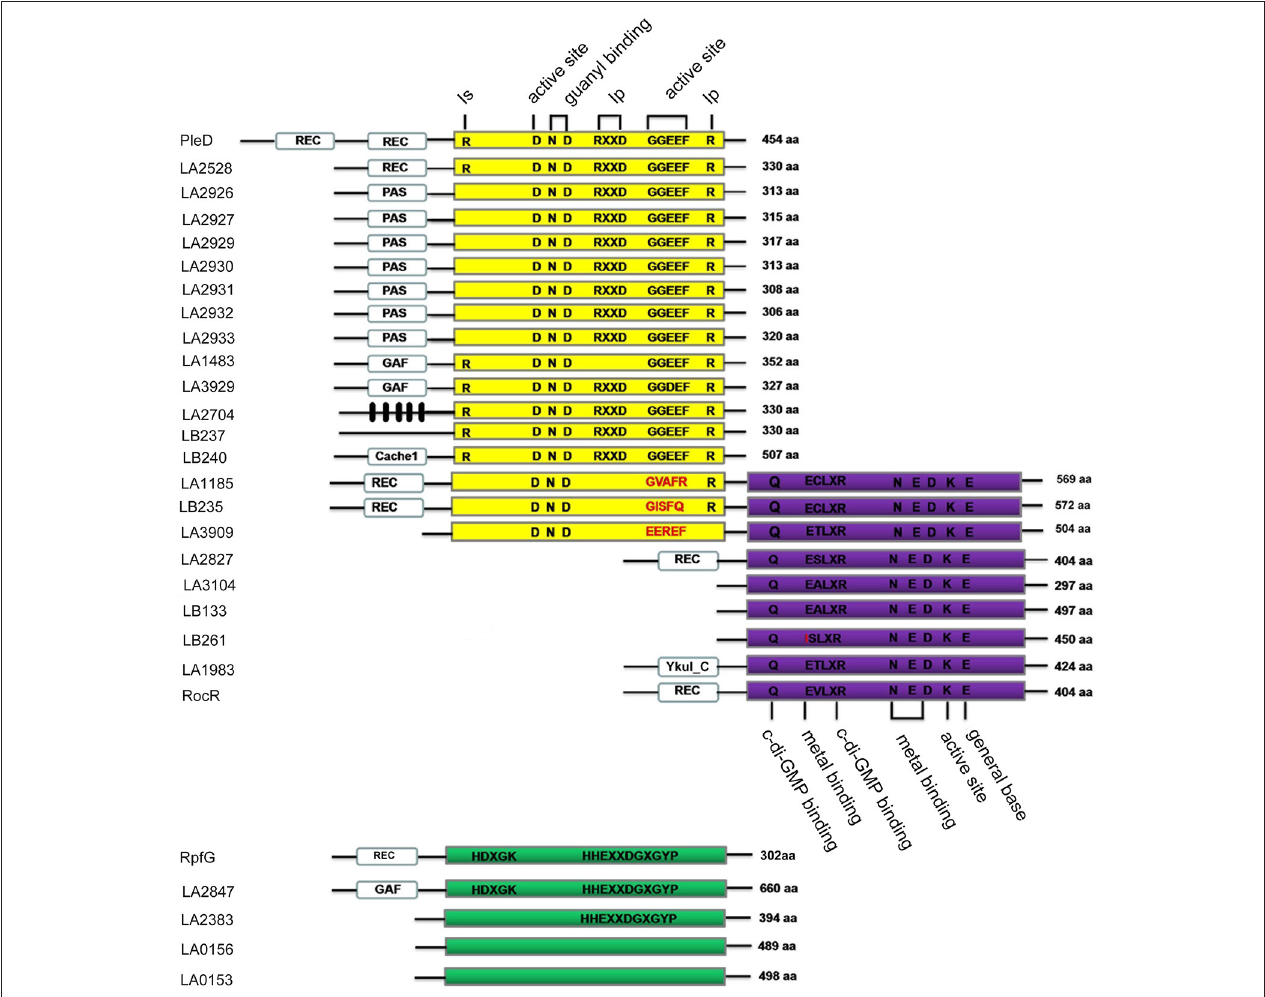
FIGURE 1 | Schematic representation of the domain architecture of c-di-GMP metabolic enzymes of L. interrogans Lai strain 56601. Protein names are marked on the left and the number of amino acids is shown on the right. Yellow, purple, and green boxes represent GGDEF domains, EAL domains and HD-GYP domains, respectively. The GGDEF domain protein PleD from C. Crescentus , the EAL domain protein RocR from P. Aeruginosa and the HD-GYP domain protein RpfG from X. campestris are used as references to highlight amino acids important for enzymatic activity (Ryan et al., 2006; Wassmann et al., 2007; Rao et al., 2008). The putative conserved functional amino acid residues are shown in black (conserved) or red (mutation). Black boxes are predicted transmembrane regions. I p is the primary inhibitory binding site for c-di-GMP, and I s is the secondary inhibitory binding site for c-di-GMP. REC, PAS, Cache1, GAF, and YkuI_C sensory domains are indicated by white